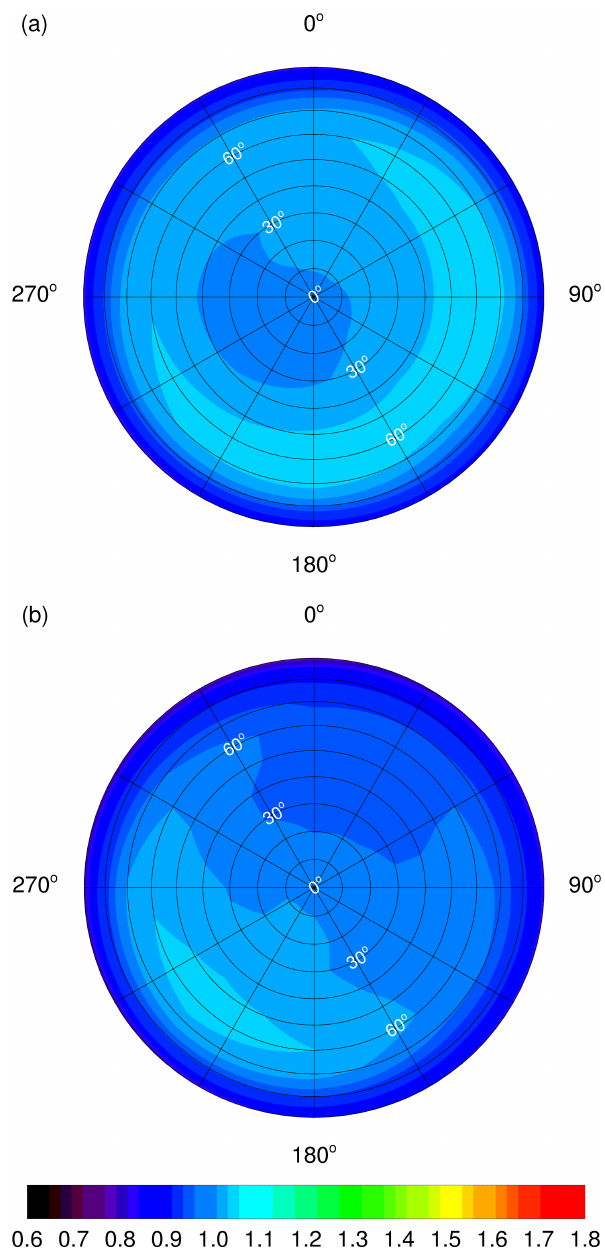
Figure 4. Contour plots of hemispherical relative angular sensitivi- ties Z p of HALO 2 π (a) and (b) receivers at 400nm (top views). Azimuth angles of 0 ◦ correspond to flight directions of aircraft- installed receivers. Polar angles of incidence are indicated (white). Note that cross-talk to the lower hemisphere is invisible in this rep- resentation. The colour scale was chosen for better comparability with Fig. 6.